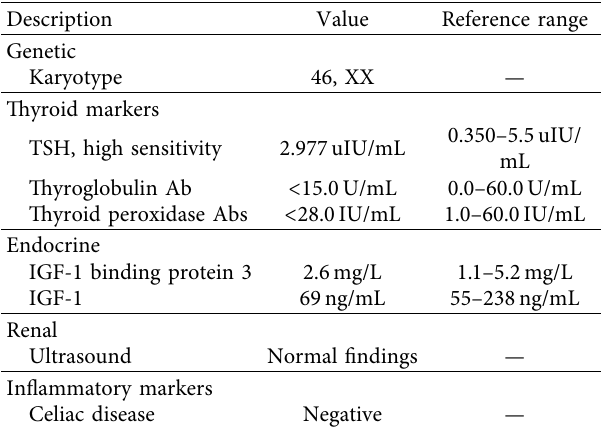
Table 1: Initial laboratory